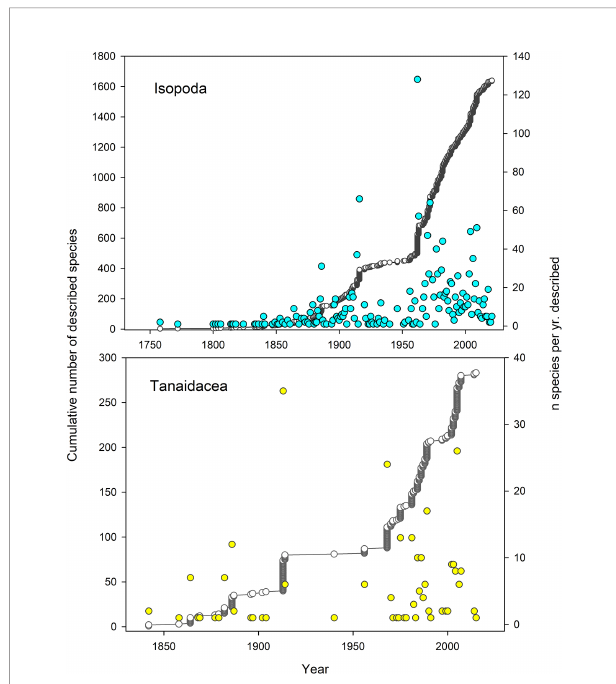
FIGURE 4 | Rate of deep-sea species descriptions within Isopoda (top) and Tanaidacea (below); the line indicates the cumulative number of species (corresponding left y-axis), and the scatter plot indicates the actual number of species described (right y-axis) per year. The average description rate in the last ten years was ~4 and 9 species for tanaidaceans and isopods respectively. Data retrieved from WoRDSS (Glover et al., 2021) and updated through WoRMS (WoRMS Editorial Board, 2021). According to WoRDSS (Glover et al., 2021) only species described from below 500 m are